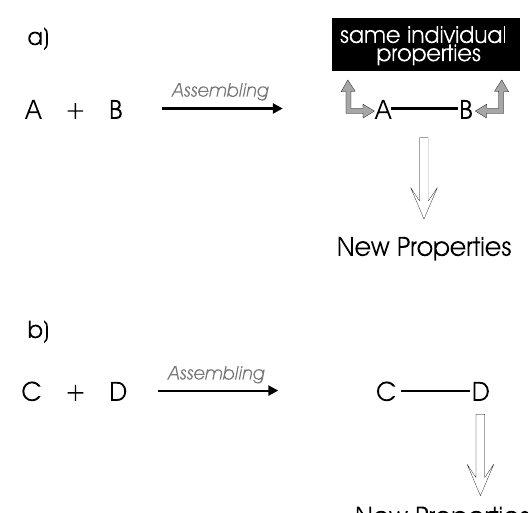
Fig. 1 – Supramolecular Effects: a) Week electronic/nuclear interaction leads to the maintenance of the individual properties; b) appreciable electronic/nuclear interactions leads to changes in the individual